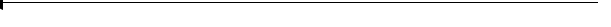
(cid:98) Fig. 9. Example of results obtained in mixed conditions. The fol- lowing time-series of parameters are represented: the channel 6 (cid:133) (cid:104) (cid:136) 15 (cid:14) (cid:134) calibrated output signal measured by the Polar Nephelo- meter (the open circles correspond to cloud-water-droplet conditions and the full circles denote the occurrence of ice crystals, see text for explanations), the raw output signal of the channel 6 (plotted at 10 Hz), the mean ice-particle size (D2D) and ice-particle, concentra- tion (C2C) measured by the 2D-C probe (1 Hz) and the mean volume diameter (MVD), droplet concentration (CONC) and liquid water content (LWC) obtained from the ASSP data (1 Hz). The wind tunnel airspeed was set to 50 m s (cid:41) 1 except during the periods represented by full line segments (in LWC graph) where an airspeed of 25 m s (cid:41) 1 was set